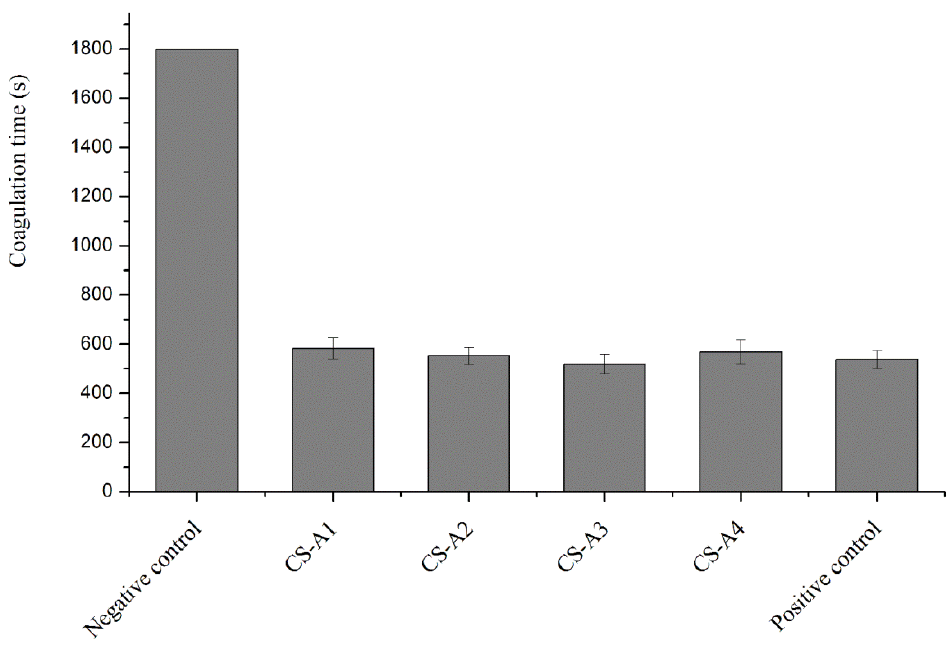
Figure 6. Effect of chitosan acid salts on coagulation time.